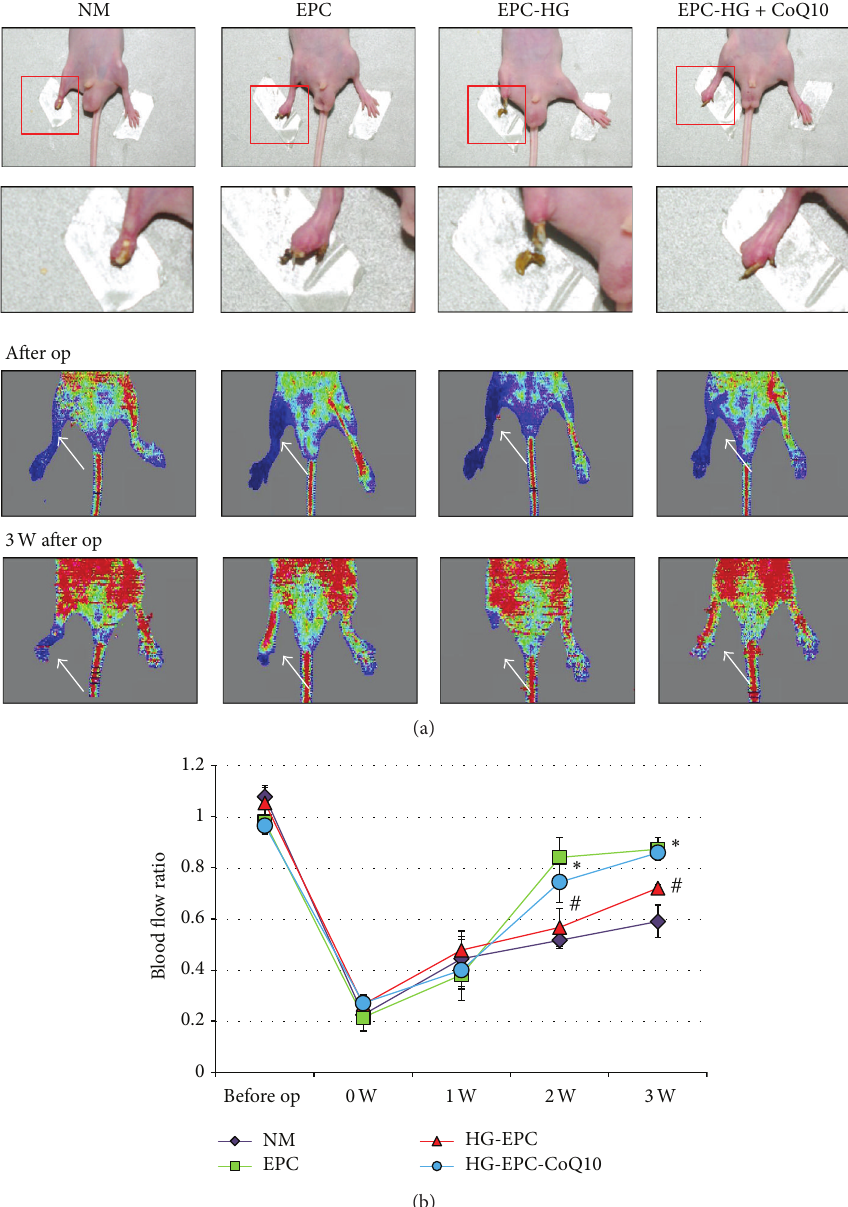
Figure 6: Effect of CoQ10-treated EPCs in high glucose medium transplantation on hindlimb perfusion. (a) Serial laser Doppler analyses of hindlimb perfusion revealed before and 3 weeks after hindlimb ischemia surgery in nude mice, which received a transplant with normal saline, EPCs, high glucose-treated EPCs, and high glucose-treated EPC incubated with CoQ10. Low or no perfusion is displayed as blue, whereas the highest perfusion is displayed as red. Arrows indicate ischemic (right) limb after hindlimb ischemia surgery. (b) Quantification analysis of perfusion recovery by laser Doppler perfusion imaging rations (ischemic/normal hindlimb) over time in the different groups. Results are mean ± SE; 𝑛 = 4 ; # 𝑃 < 0.05 versus control (5 mM glucose); ∗ 𝑃 < 0.05 versus high glucose